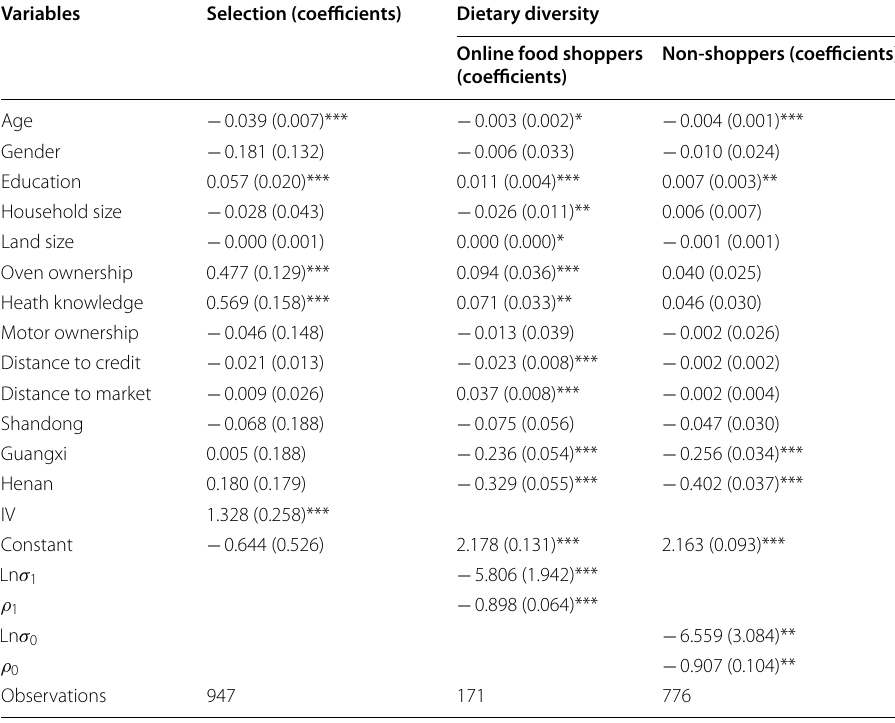
* p < 0.10, ** p < 0.05, and *** p < 0.01. The reference province is Sichuan. Robust standard errors are presented in